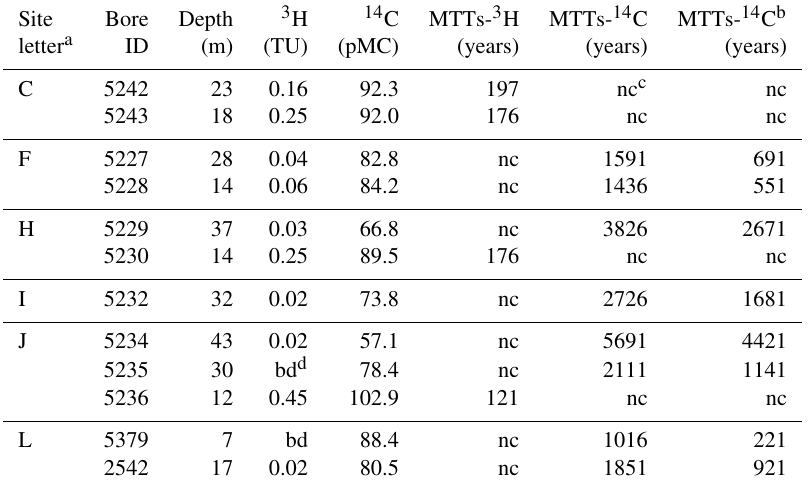
Table 2. 3 H, 14 C activities, and calculated MTTs by EPM (ratio = 0.33) of groundwater from the upper Wimmera River.